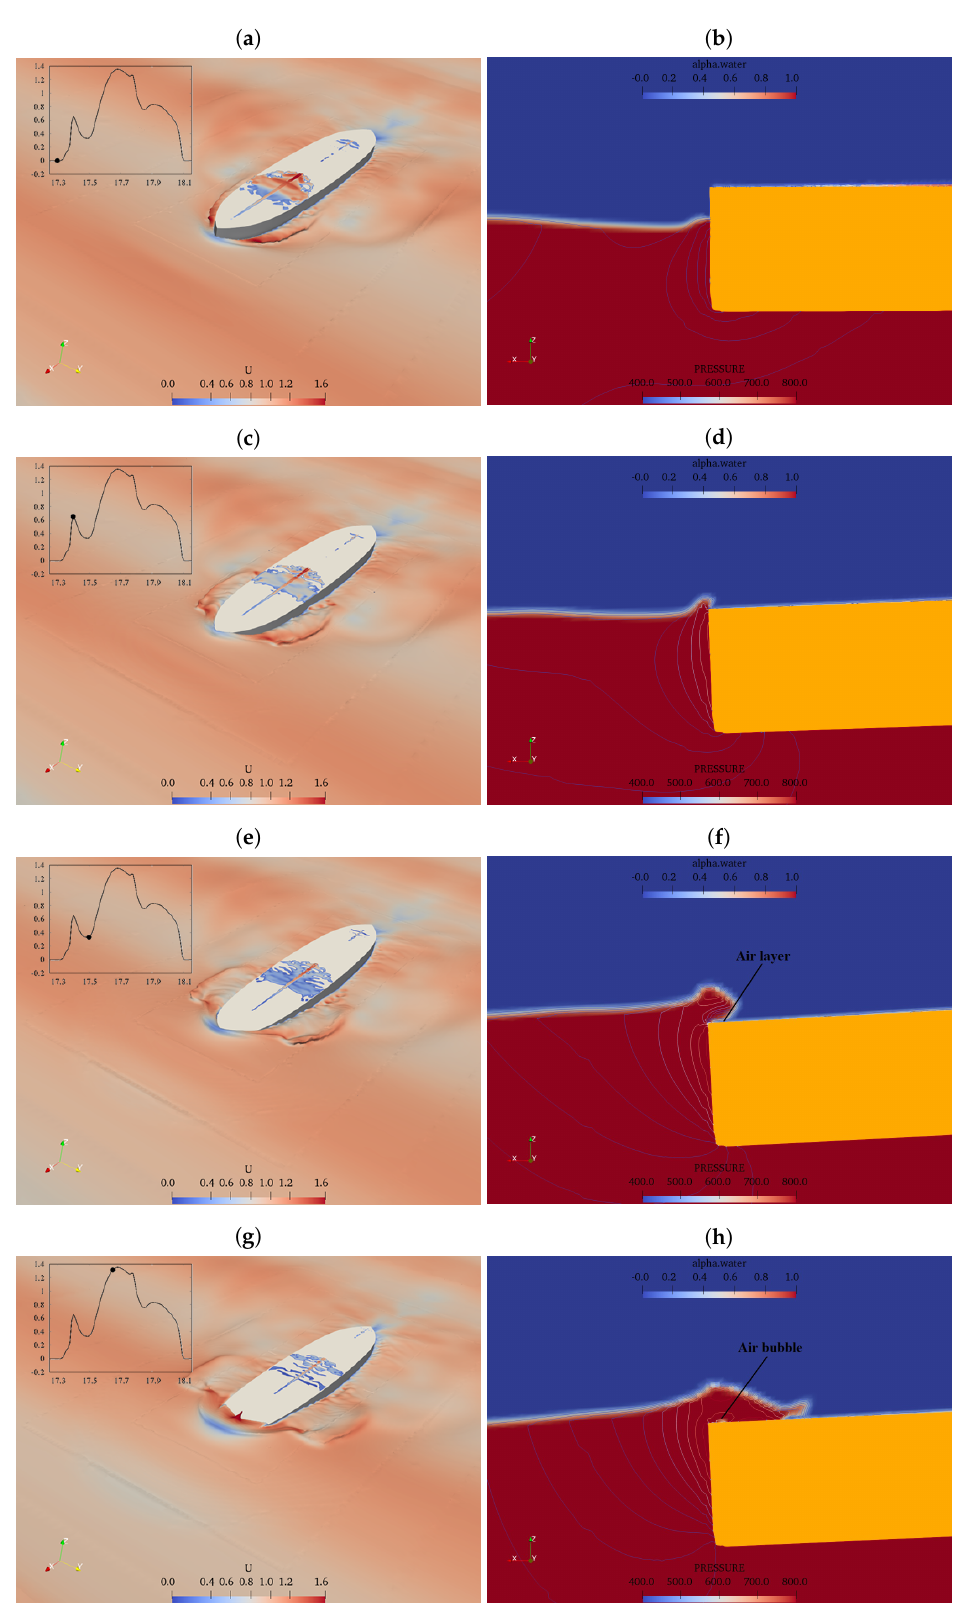
Figure 11. Flow velocity contours on the free surface ( a , c , e , g ) and pressure contours on the x – z plane at y = 0 ( b , d , f , h ) at time instants 1–4 for λ / L =